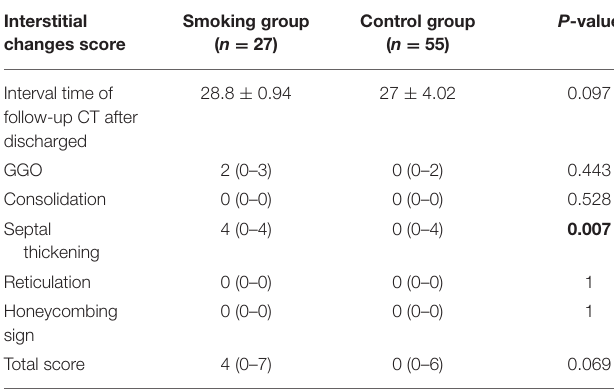
TABLE 3 | CT features of follow-up CT when